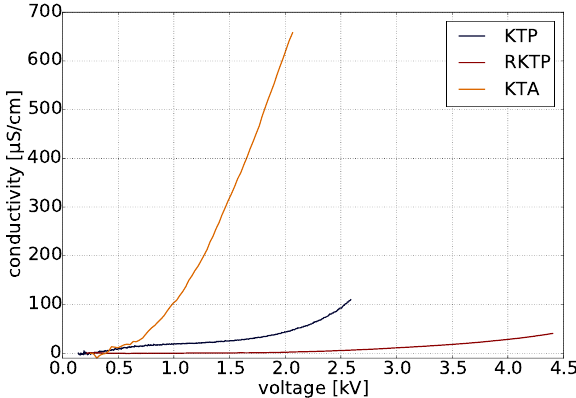
Figure 1. Measured ionic conductivities for KTA, KTP, and